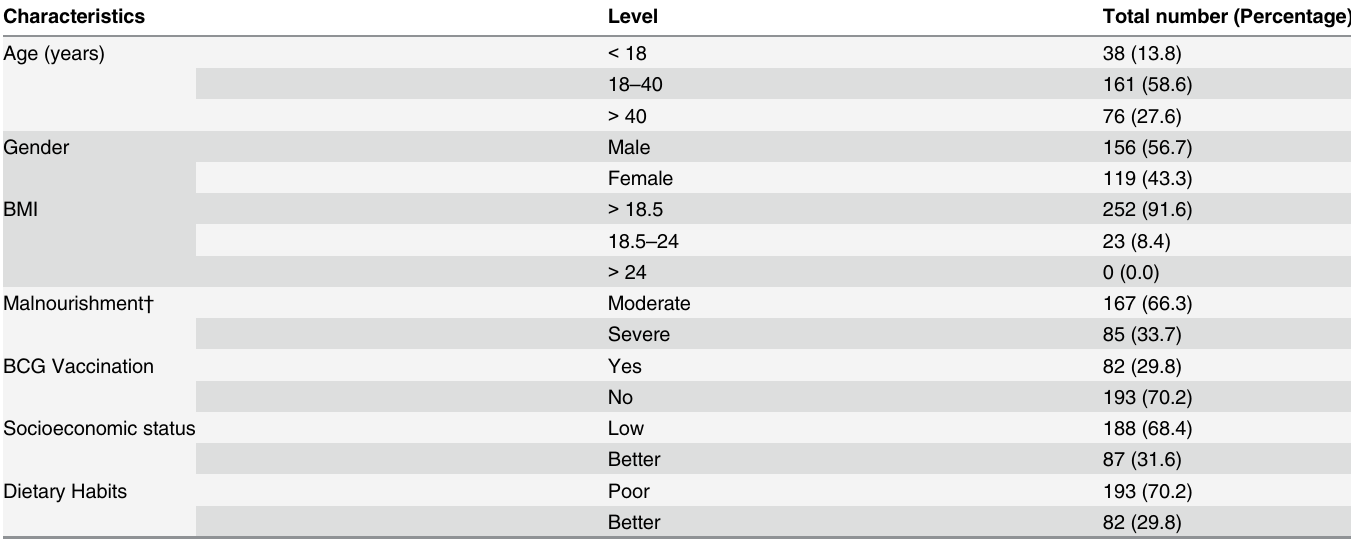
Table 1. Demographic characteristics of the population under study.